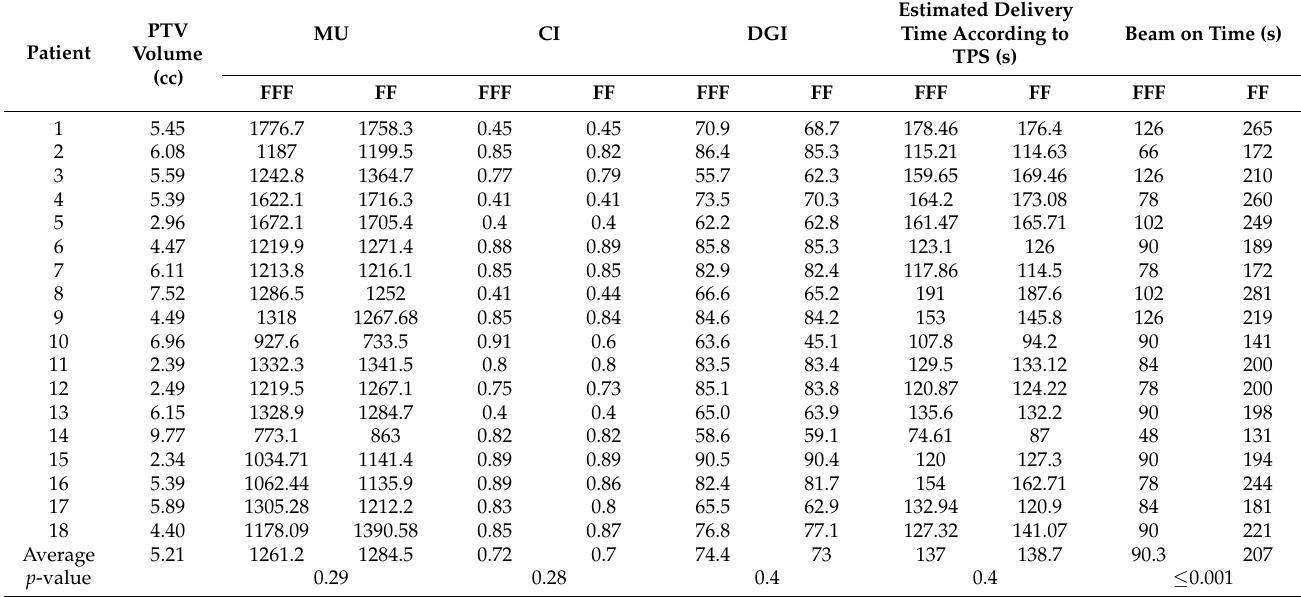
Table 4. Physical dosimetric parameters.